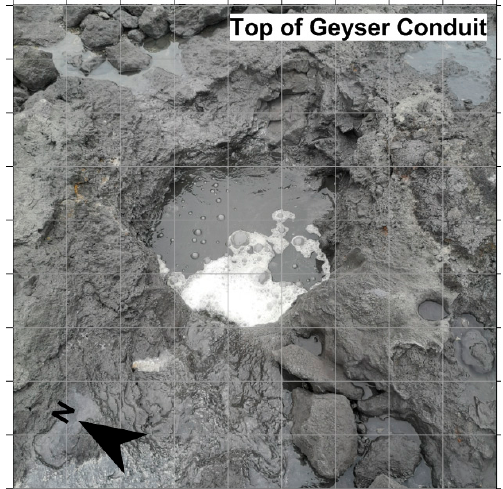
Figure A4. Shaman geyser pool pre-eruption infrared (IR) (testo-865) view. Photo by A. Kiryukhin, 24 August 2019.